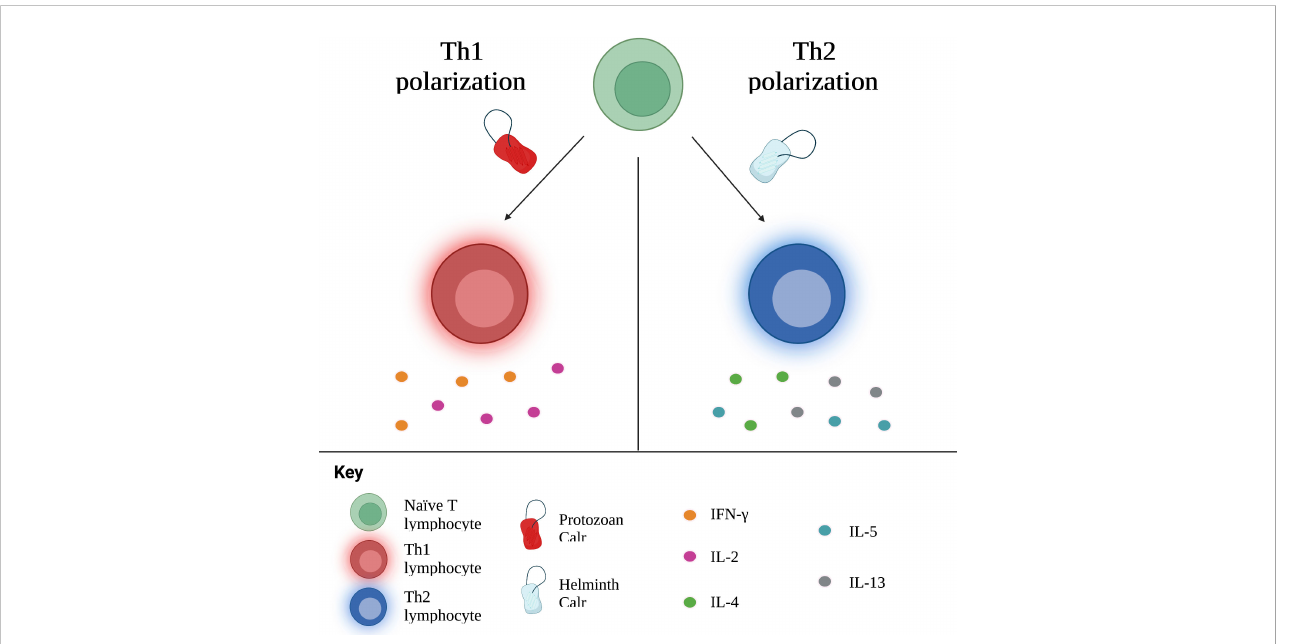
FIGURE 3 Calr in fl uences the polarization of naïve T cells towards Th1 or Th2 subtypes, with concurrent production of associated cytokines. In general, Calr derived from protozoans induces a Th1 response, whereas helminth Calr favors a Th2 response. Th, T helper; IFN, interferon; IL,